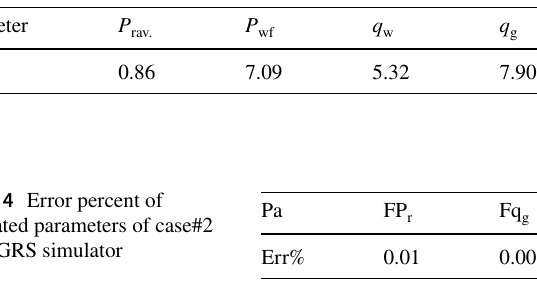
Fig. 15 Schematic of Cartesian gridding in Eclipse simulator